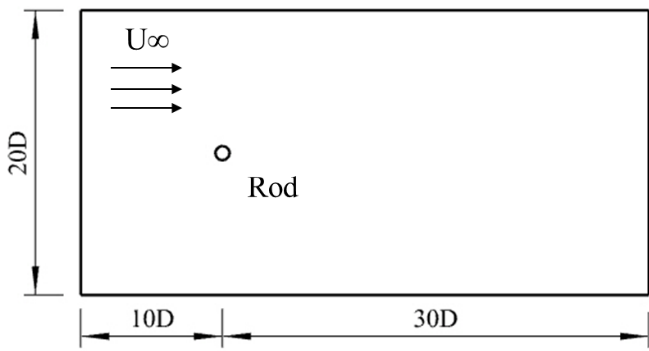
Figure 1. Schematic diagram of the computational domain for the validation.